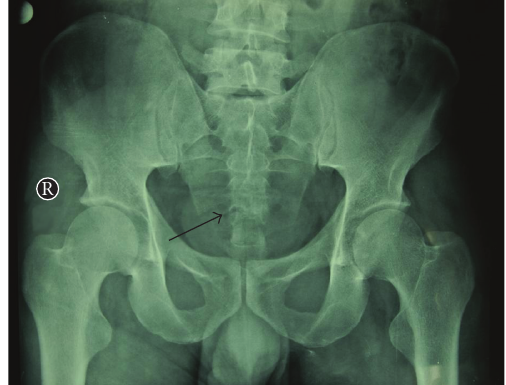
Figure 1: The anteroposterior roentgenogram of the lumbosacral area demonstrating a transverse fracture line at the right and anterior aspect of the fourth sacral